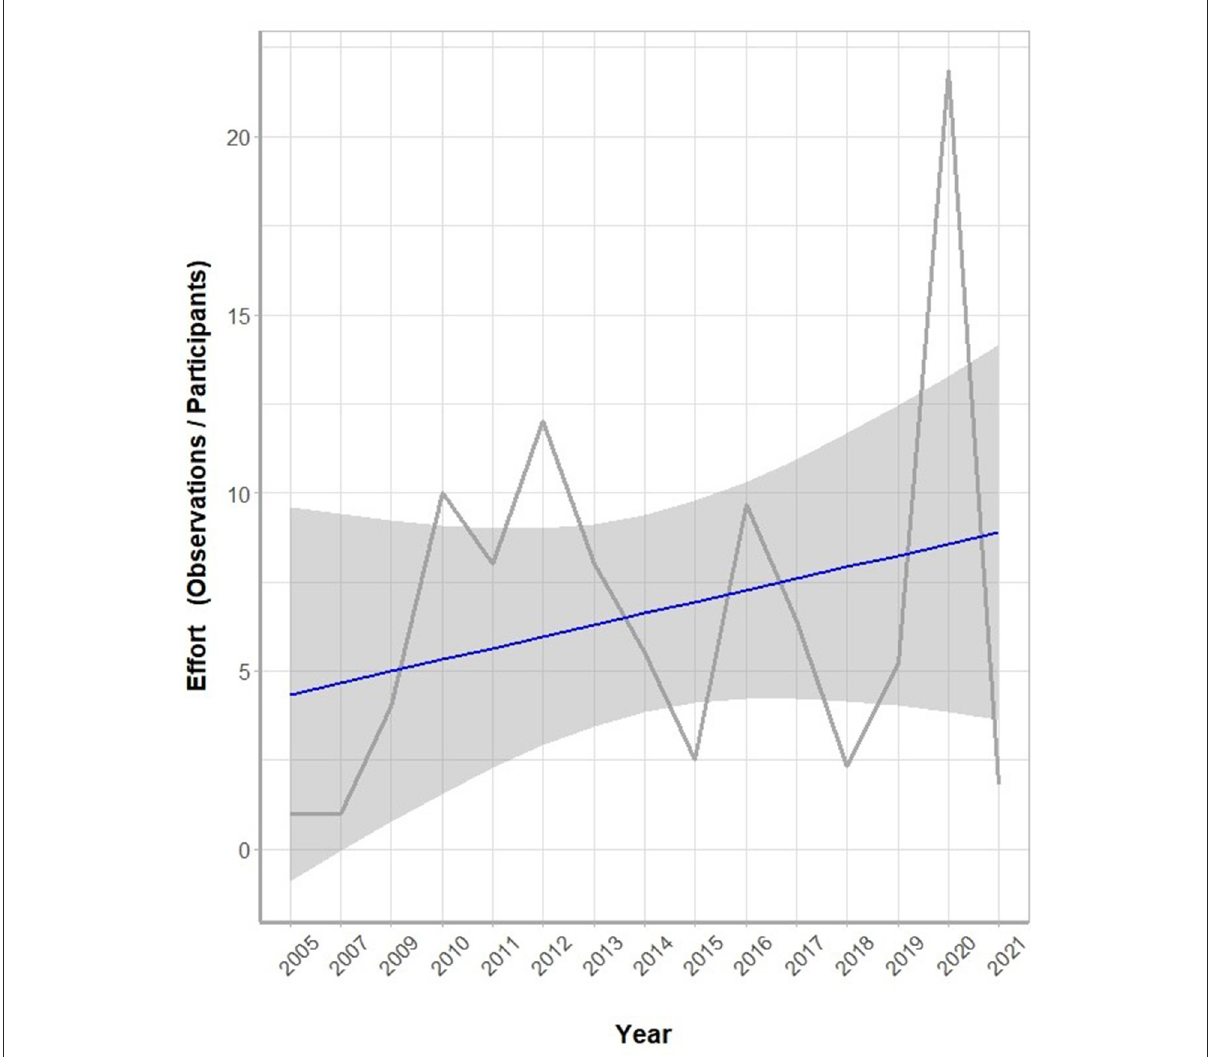
FIGURE8 The yearly sampling efforts of the iNaturalist roadkill observations through the years 2005 to 2021 (from 1 January 2005 to 13 August 2020). Here, the yearly sampling effort is expressed as the number of observations per year divided by the number of participants per year. Overall, the sampling efforts show an increasing trend through the years. The trend line (blue) is shown with 95% confidence interval.